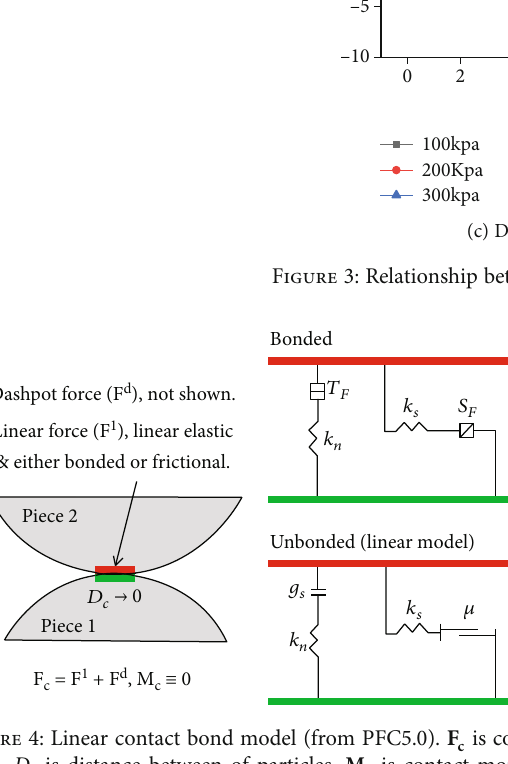
is speci fi c gap. k s